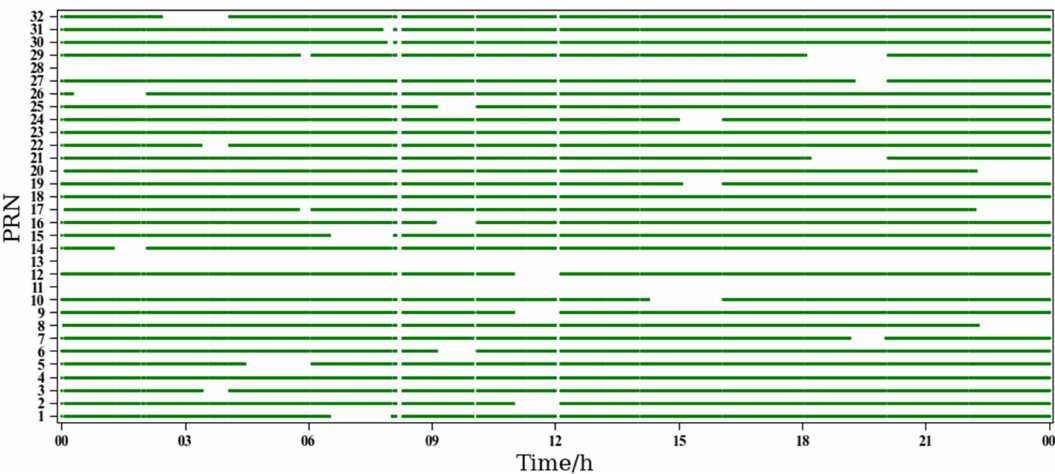
Figure 3. Time series of SSR correction from NRC on day of the year (DOY) 144 of